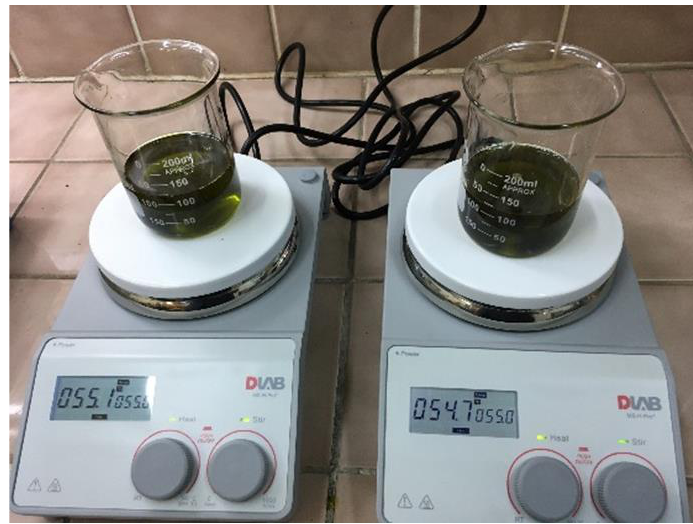
Figure 5. Preparation of hemp oil for bleaching. After the bleaching process, the mixture was poured into a Buchner funnel (Figure 6). Cellulose filters were used for filtration, on which bleaching earth was deposited. Filtration continued until a dry post-filter cake was obtained. The filtration time was unique and de- pended on the amount and type of soil used.